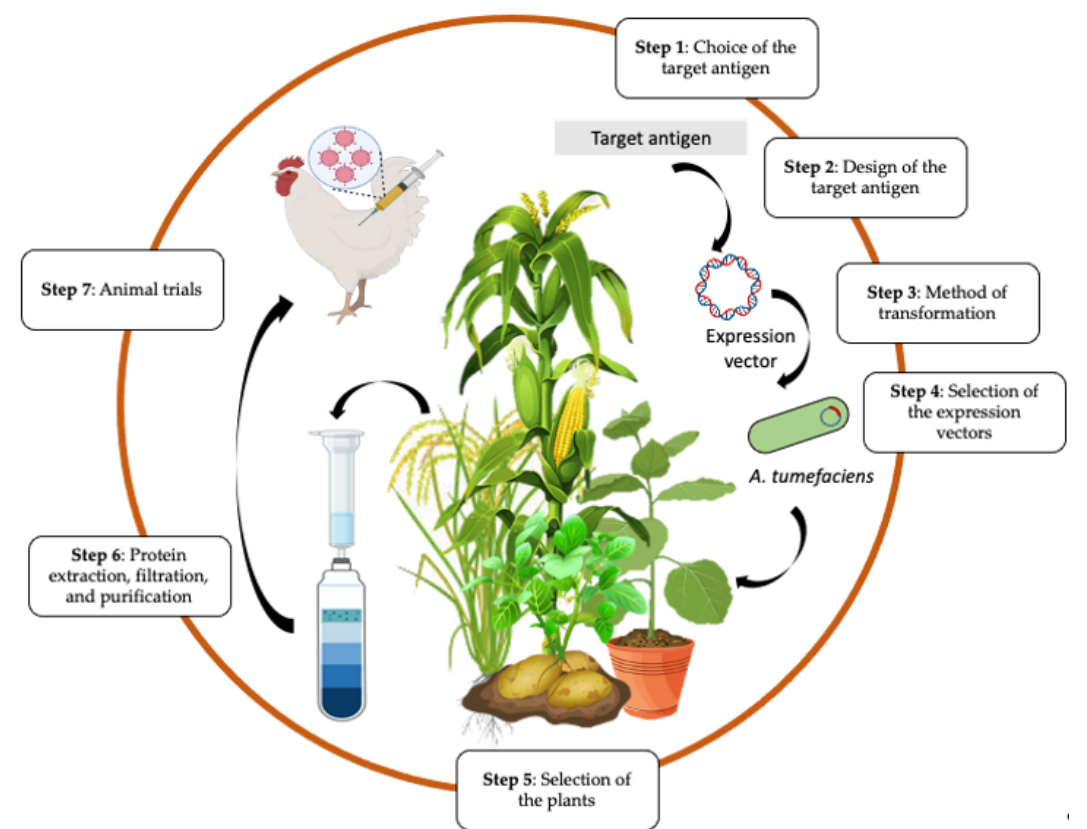
Figure 3. Summary of steps for production of plant-based vaccines. Created using some elements from Biorender.com (modified from Takeyama et al. [44]).